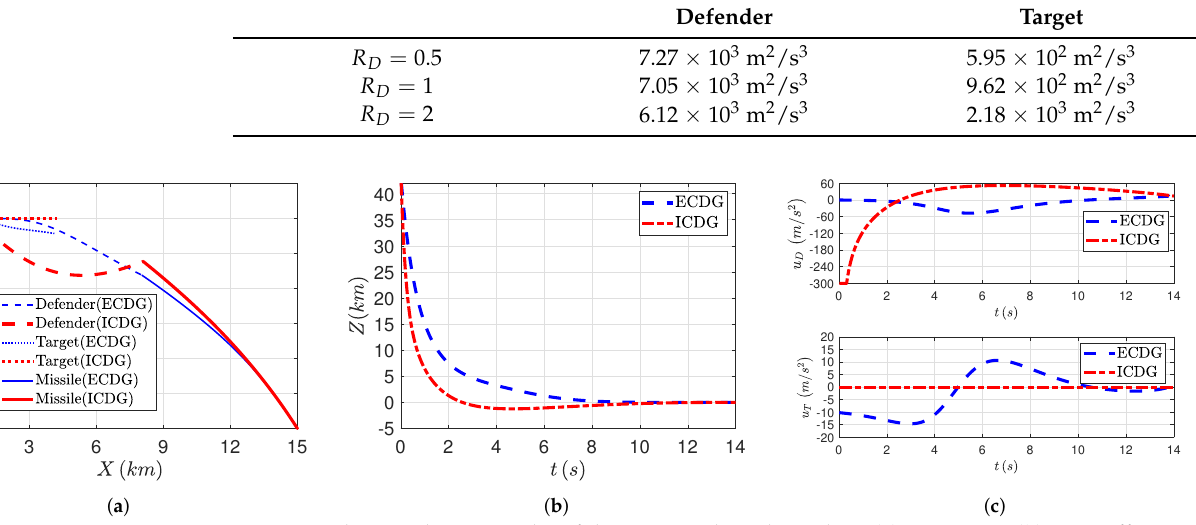
Table 2. Control Effort of ECDG with Different R D .